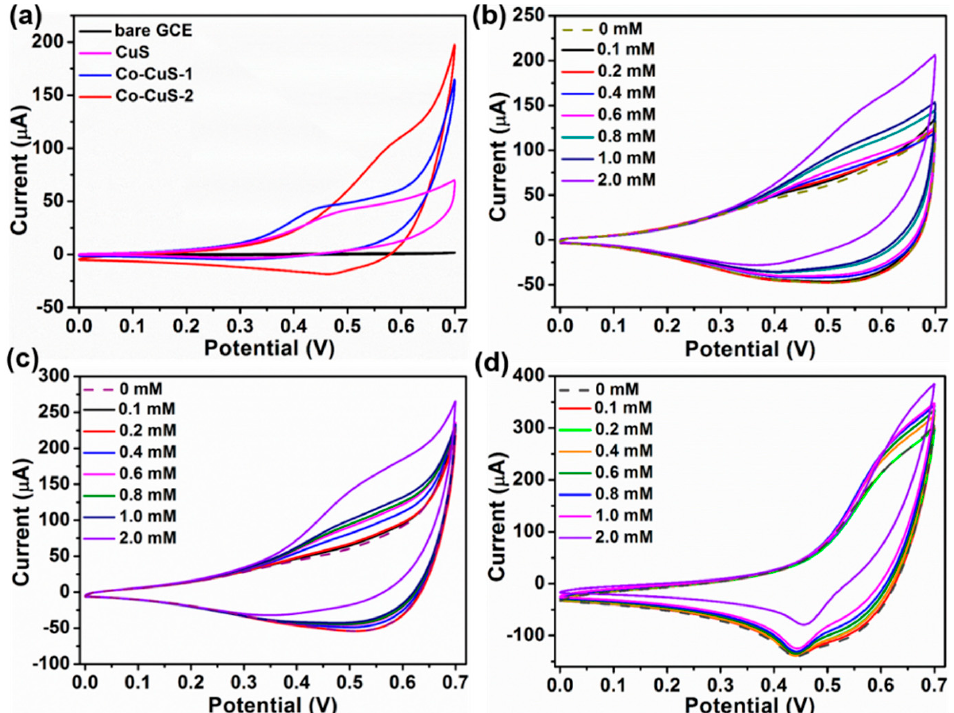
Figure 5. ( a ) CV curves of CuS, Co-CuS-1, Co-CuS-2 and bare electrode in 0.1 M NaOH electrolyte containing 1 mM Glu (20 mV · s − 1 ). CV curves in NaOH solution with different glucose concentration: ( b ) CuS, ( c ) Co-CuS-1, and ( d ) Co-CuS-2 (100 mV · s − 1 ).